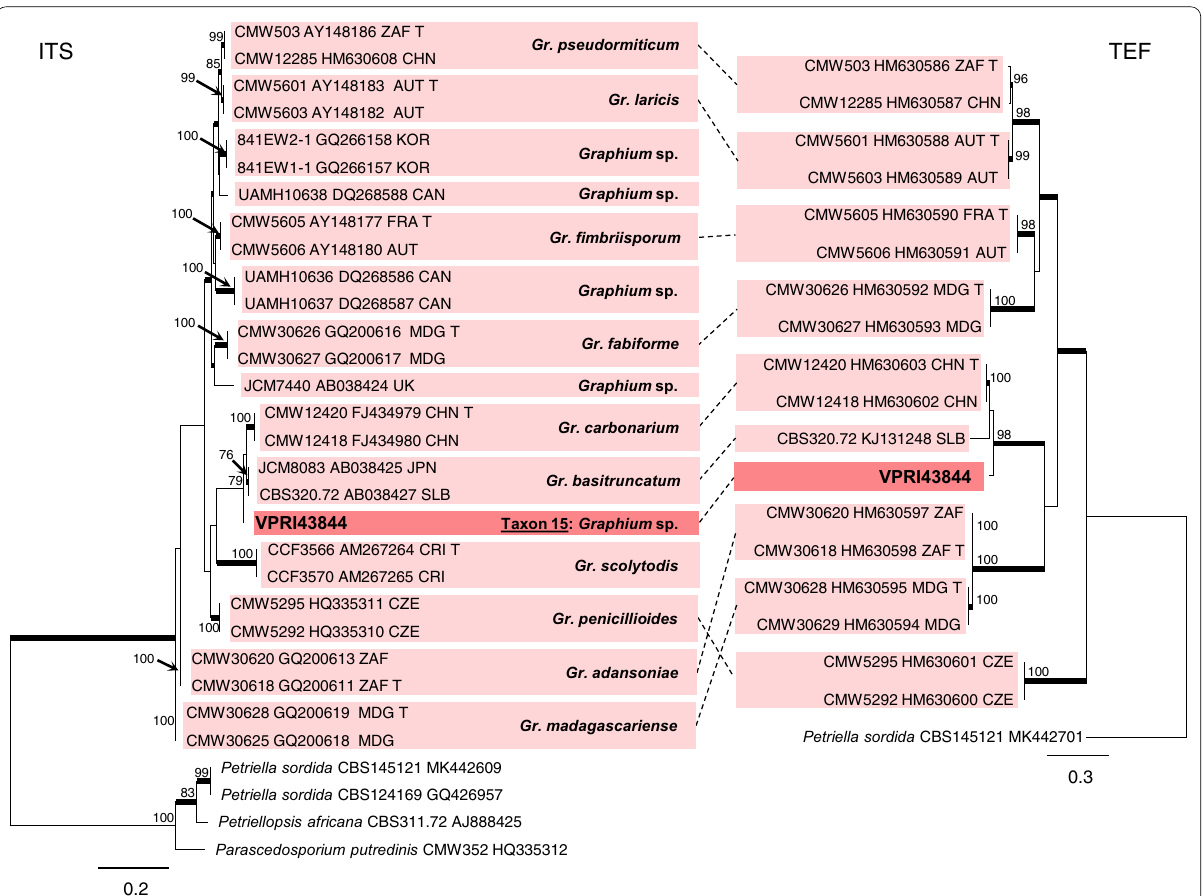
Fig. 8 ML phylogenies of Graphium isolates generated from ITS and TEF sequence data. Sequences generated in this study are printed in bold type. Bold branches indicate posterior probability values